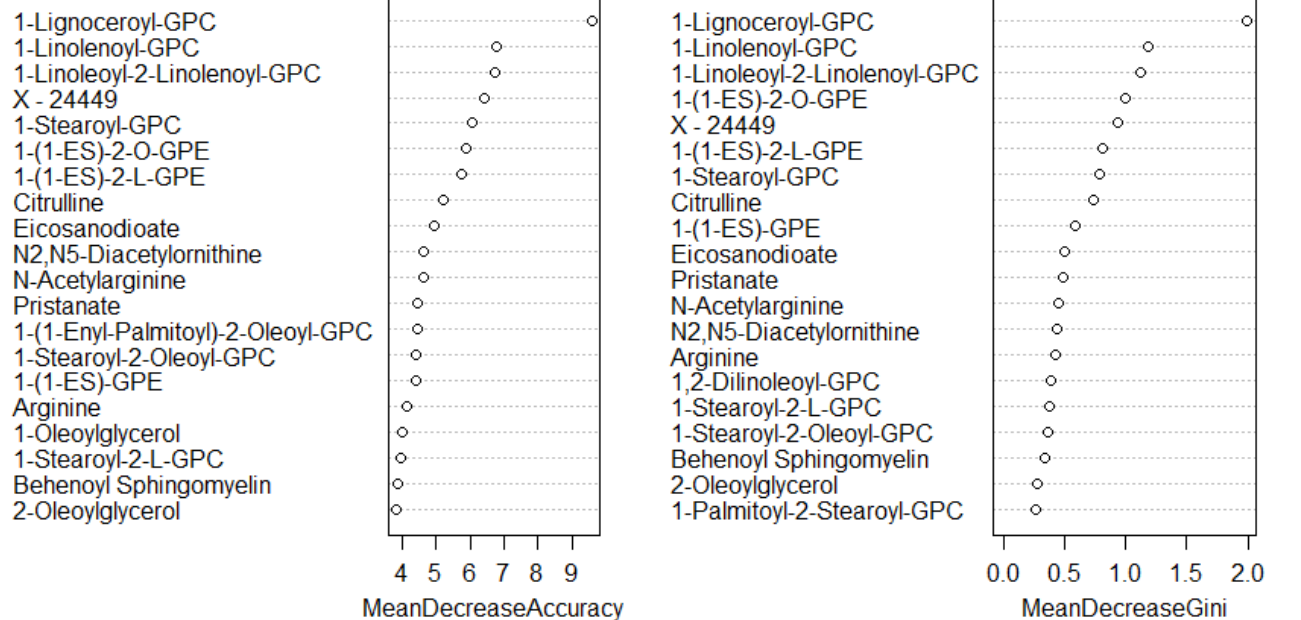
Figure 12. Top 20 discriminatory metabolites for the detection of endometrial cancer following exclusion of women with type 2 diabetes mellitus (training set: n = 72, cancers = 40, controls = 32) Metabolites were identified by random forest machine learning technique and ranked by their contribution to classification accuracy using mean decrease accuracy and mean decrease gini index. Metabolites starting with X are unnamed; the pathways of these are unknown.